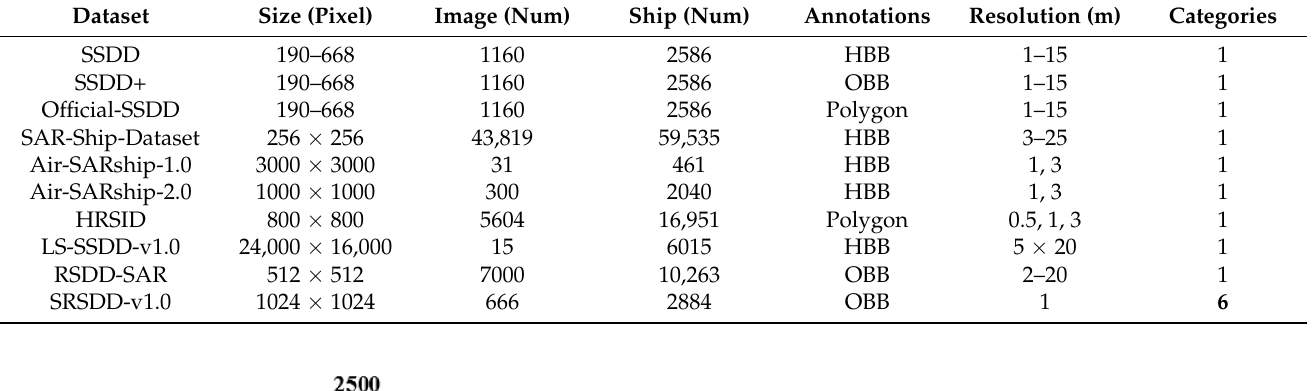
Table 1. Comparison of different SAR ship datasets.